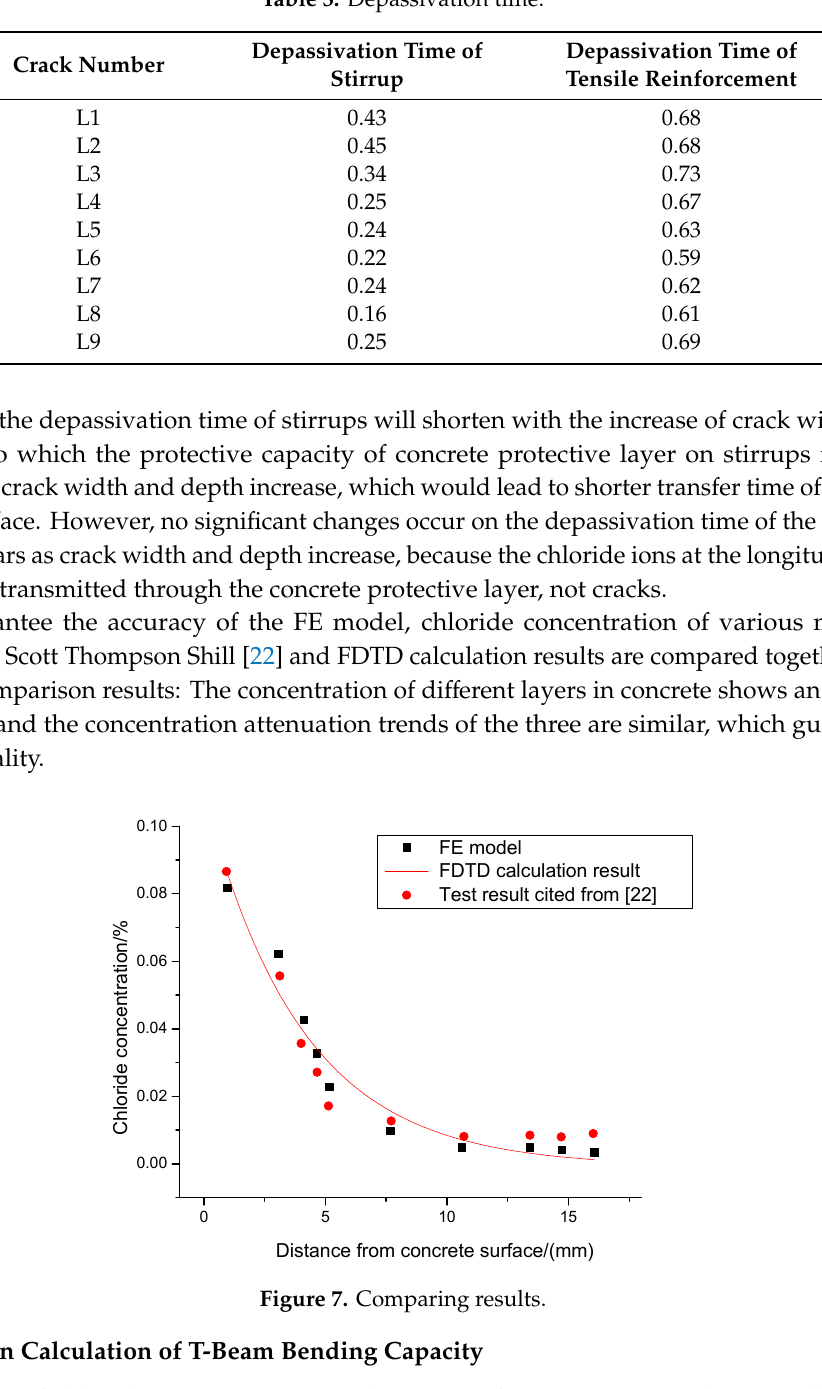
Table 3. Depassivation time.